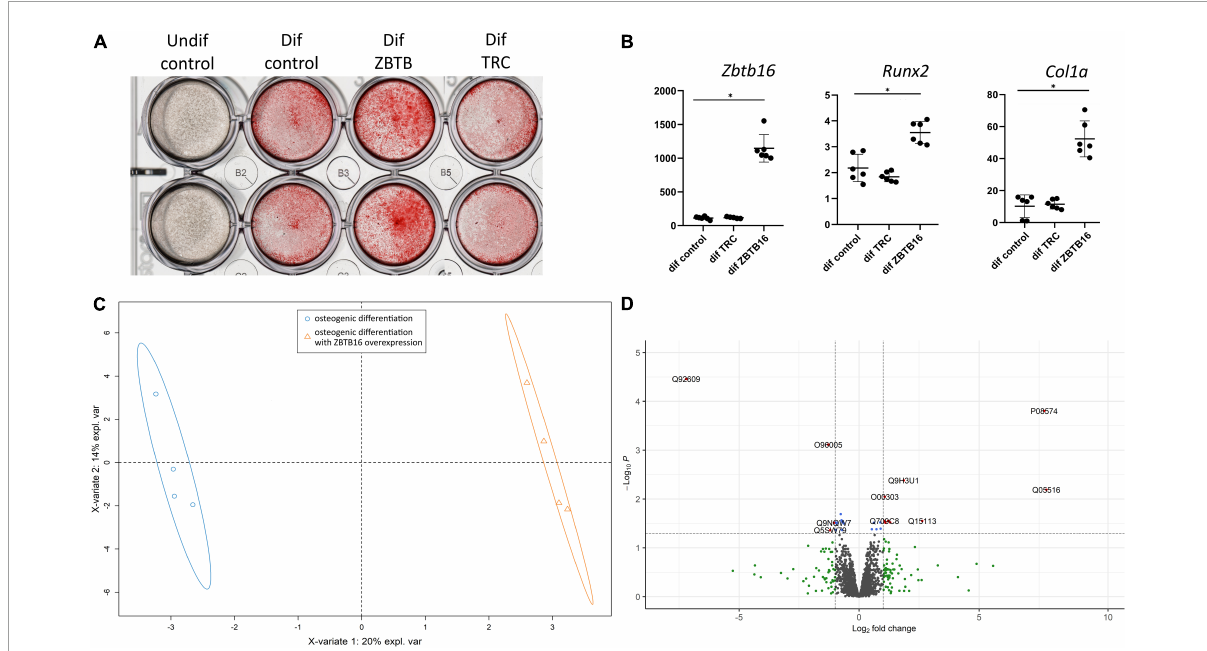
FIGURE6 Effect of ZBTB16 (PLZF) on human valve interstitial cells (VIC) osteogenic differentiation. (A) Results of Alizarine red stain of VIC cultured in standard medium (undif control), osteogenic medium (dif control), osteogenic medium with transduction by an empty vector (dif TRC), osteogenic medium with transduction by construction for ZBTB16 overexpression (dif ZBTB). (B) Results of qPCR of Zbtb16 , Runx2, and Col1a in VIC cultured in standard medium (undif control), osteogenic medium (dif control), osteogenic medium with transduction by construction for ZBTB16 overexpression (dif ZBTB). * p -value < 0.05. (C) Clusterization by sparse partial least square discriminant analysis (sPLS-DA). (D) Volcano plot demonstrating results of analysis of differential expression by limma between VIC in osteogenic conditions and VIC in osteogenic conditions with ZBTB16 overexpression. Log 2 fold change—level of change in expression -Log 10 P—logarithm of adjusted p–value. Dotted lines cut off transcripts with adjusted p -value < 0.05 and Log 2 fold change >